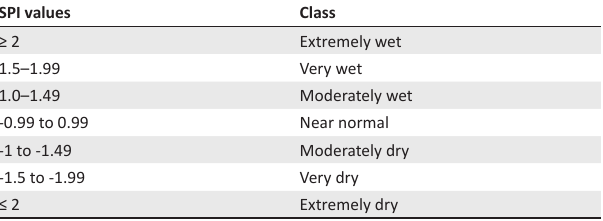
TABLE 1: Drought classification based on Standard Precipitation